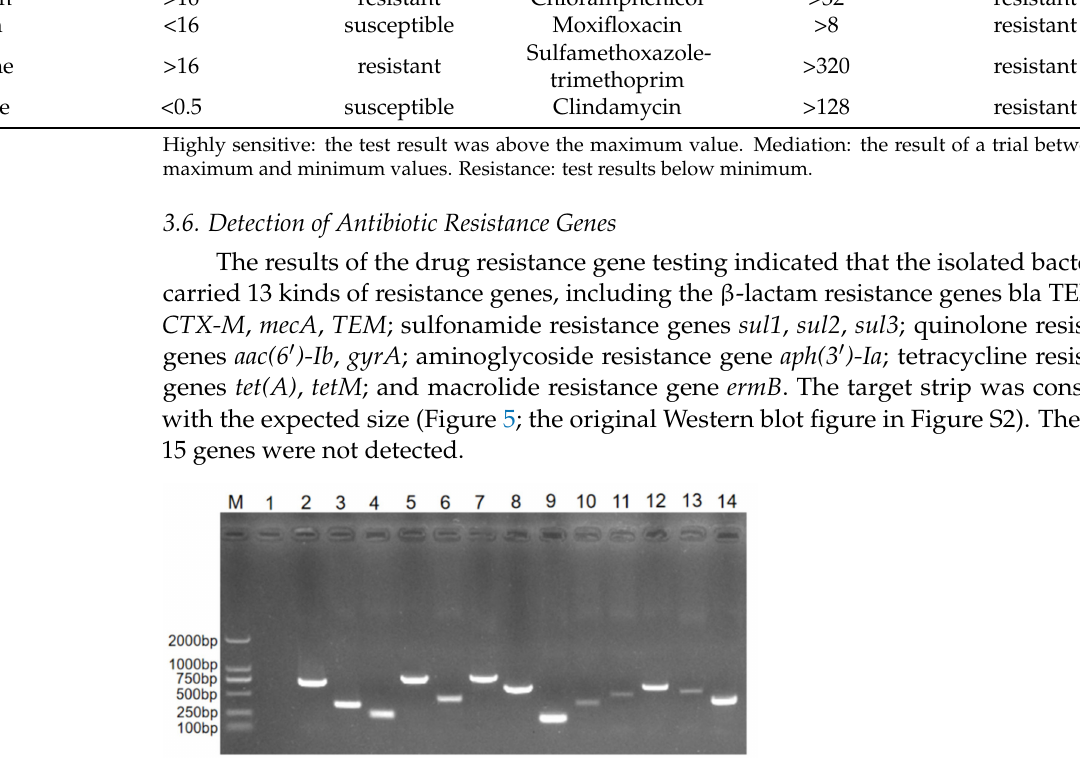
Figure 5. PCR results of drug resistance genes (cropped). Lane M: DL-2000 marker; Lane 1: negative control; Lanes 2–14: drug resistance genes: bla TEM , bla CTX-M , sul1 , sul2 , sul3 , gyrA , aph(3 (cid:48) )-Ia , tet(A)